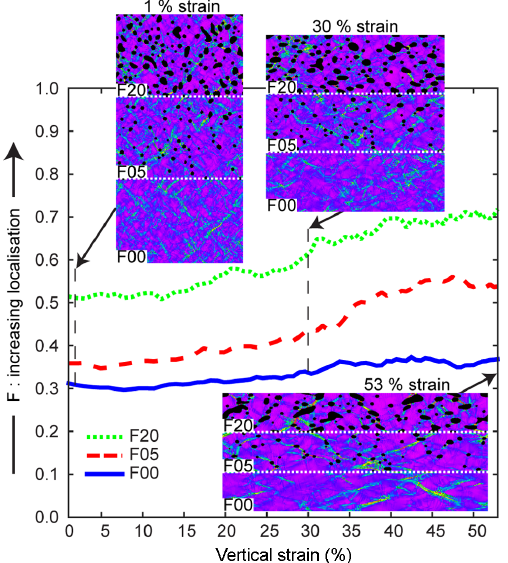
Figure 4. Evolution of localization factors ( F ) with strain quanti- fying strain localization in the microstructures for all simulations. A factor of 0 represents homogeneous deformation; the factor in- creases towards one with increased strain-rate heterogeneity and lo- calization. The normalized von Mises strain-rate maps at 1, 30 and 53% vertical strain are shown for reference. The maps are subdi- vided to show results of simulation F20 in the upper third, F05 in the middle and F00 in the lower third part of the model box. They illustrate strain localization at different stages of the